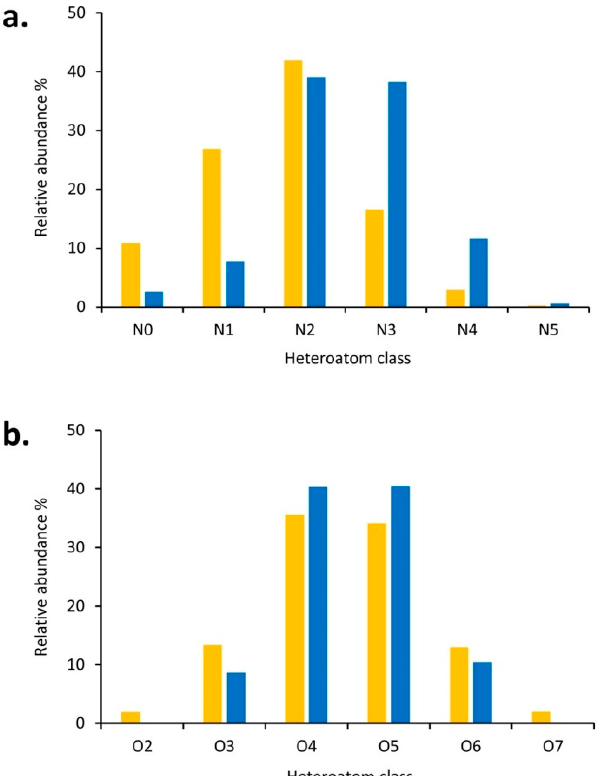
Figure 2. Relative distributions of the positive ions for different compound classes observed in the study of a pyrolysis bio-oil when ammonia (yellow) or ammonium acetate (blue) was added with respect to ( a ) the number of nitrogen atoms for CxHyN 0–5 O 2–7 compounds and ( b ) the number of oxygen atoms for CxHyO 2–7 species. Reprinted from Hertzog et al., with permission from the American Chemical Society [23].